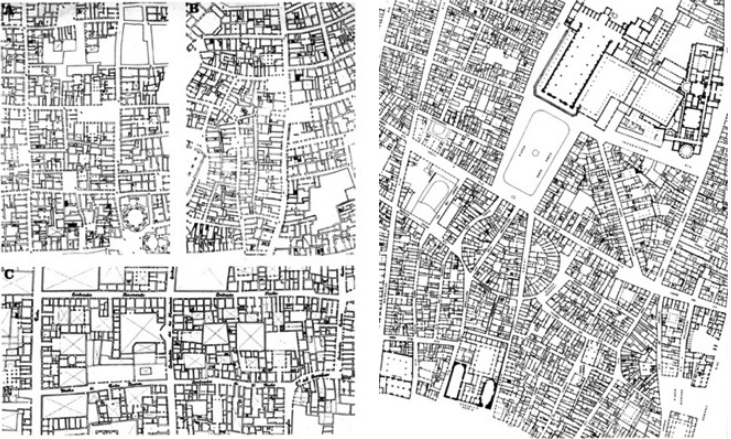
Figure 11. The typological survey of the ground floors. From left to right: Saverio Muratori, wall surveys in Genoa and Como (Muratori, 1963); Aldo Rossi, typological survey of the S. Croce district in Florence (Rossi,